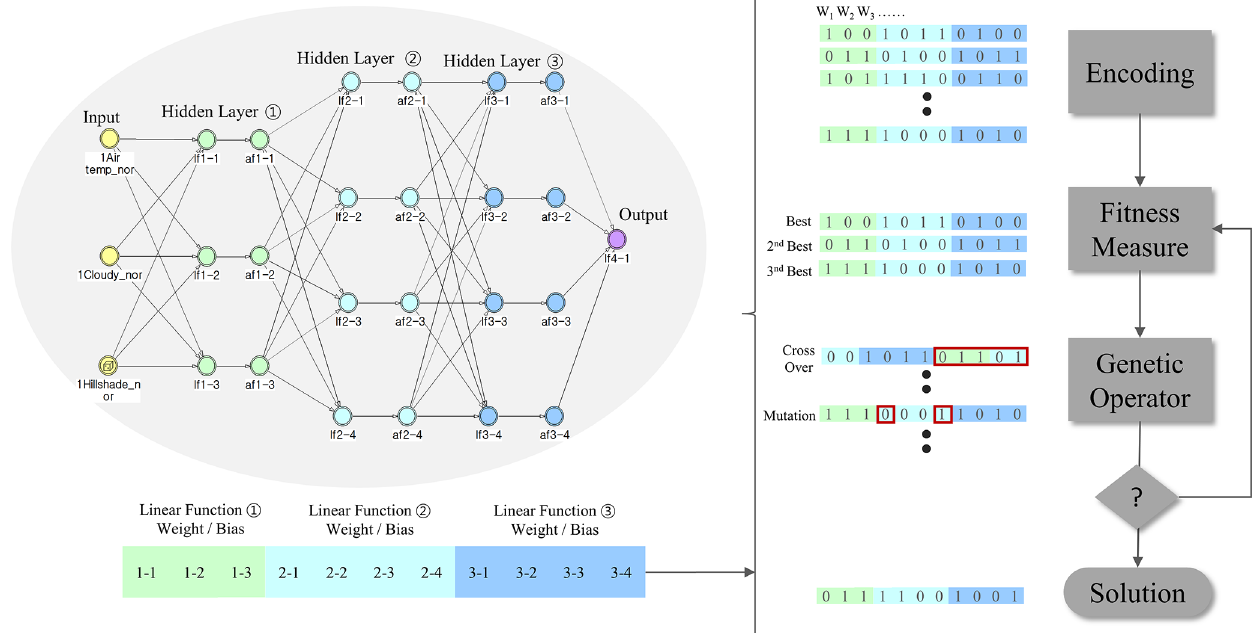
Figure 3. Structure of system dynamics of deep neural network for road temperature modelling. (a) Change the parameters of DNN in the form of the chromosome. (b) The fitness function of the chromosome is evaluated and input to the genetic operator. (c) It performs selection to select chromosomes with high fitness, crossover to mix gene values, and mutations to simulate mutations in gene values. (d) Choose a solution based on the goodness of